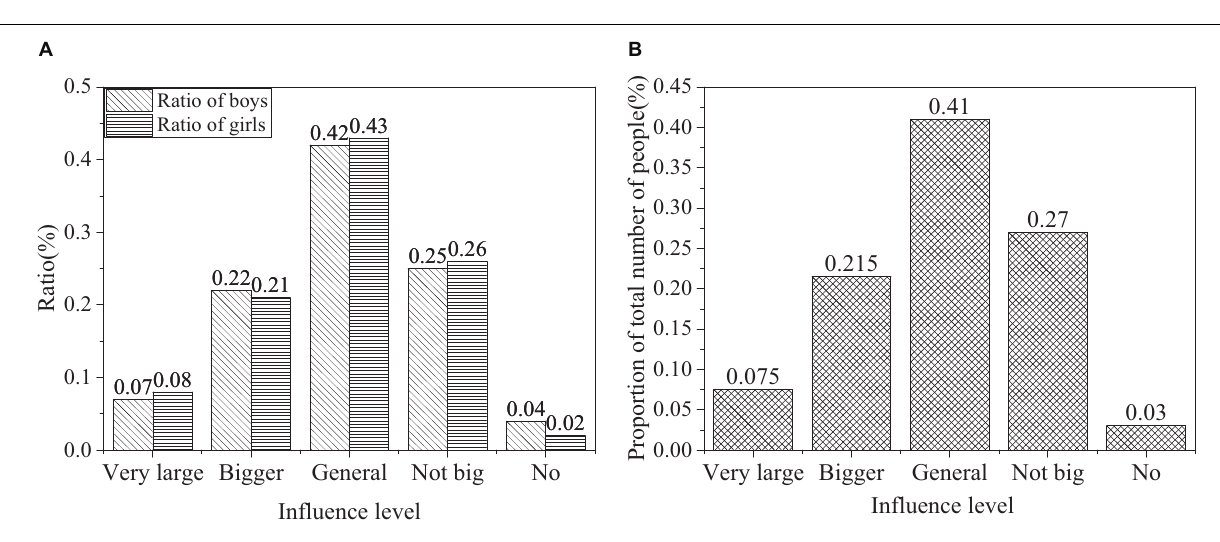
FIGURE 8 | Influence of network information on attitude of college students toward society [ (A) the ratio of males and females; (B) the ratio of